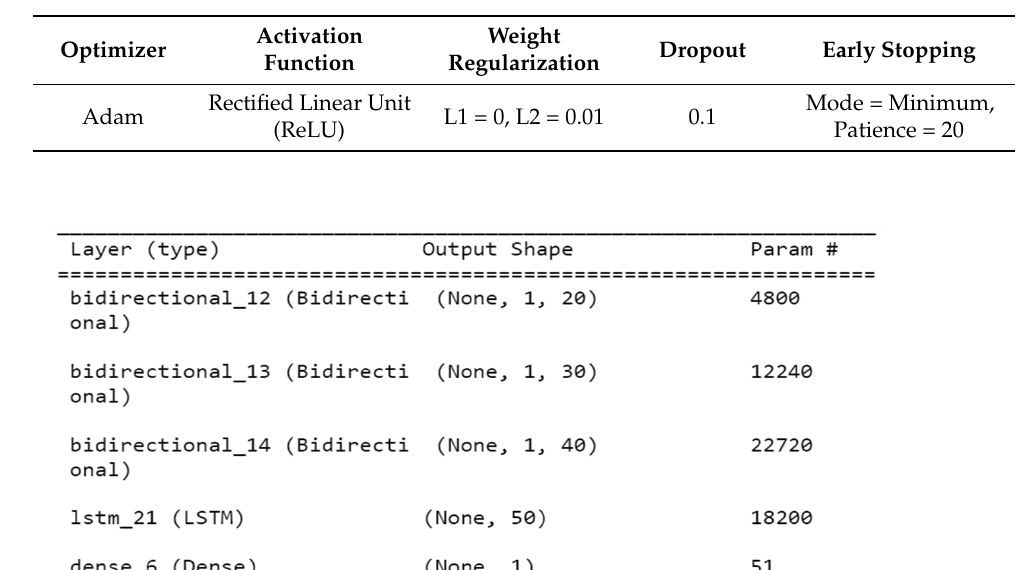
Table 4. The grid-search hyperparameter optimized parameters for BiLSTM modelling.